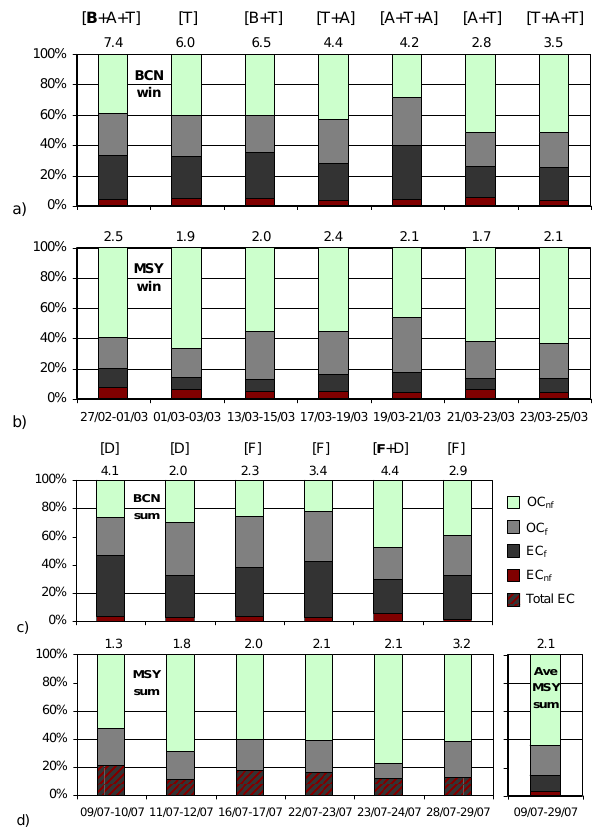
Fig. 4. Variation of the fossil (f) and non-fossil (nf) fractions of EC and OC during the study periods (date format: dd/mm). The atmospheric scenarios and the total carbon concentrations are listed on top of each bar in µgm − 3 . Scenario A: air masses recirculation and accumulation of pollutants (MSY and BCN within the mixing layer); B: mixing layer height below MSY; D: regional pollution; F: air masses from North Africa; T: transition between different scenarios. In bold the prevailing scenario when more than one oc- curred during the same sampling period. (a) winter BCN; (b) winter MSY; (c) summer BCN; (d) summer MSY. For summer MSY, no distinction of EC f vs. EC nf is given for the individual days, because samples were pooled for analyses (see text).